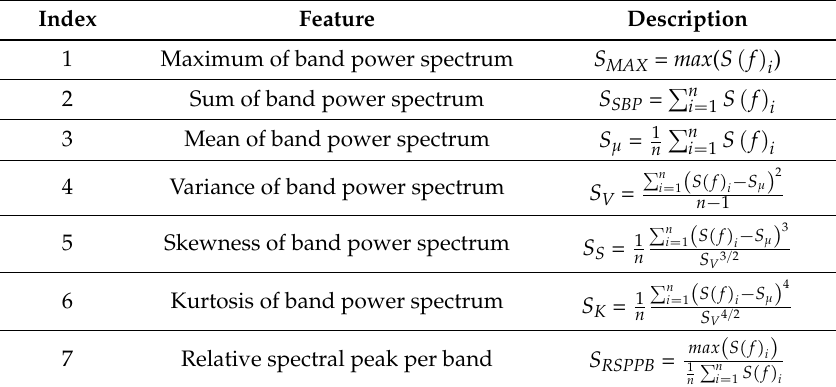
Table 2. Features extracted in frequency domain.